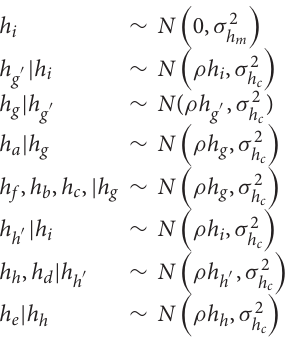
are denoted as edges, and mutated sites are denoted with a number on edges. For example, the ancestral haplotype i has allele sequence 0000000 , and the haplotype g with sequence 1000100 differs from the ancestral haplotype due to mutations at the sites 5 and